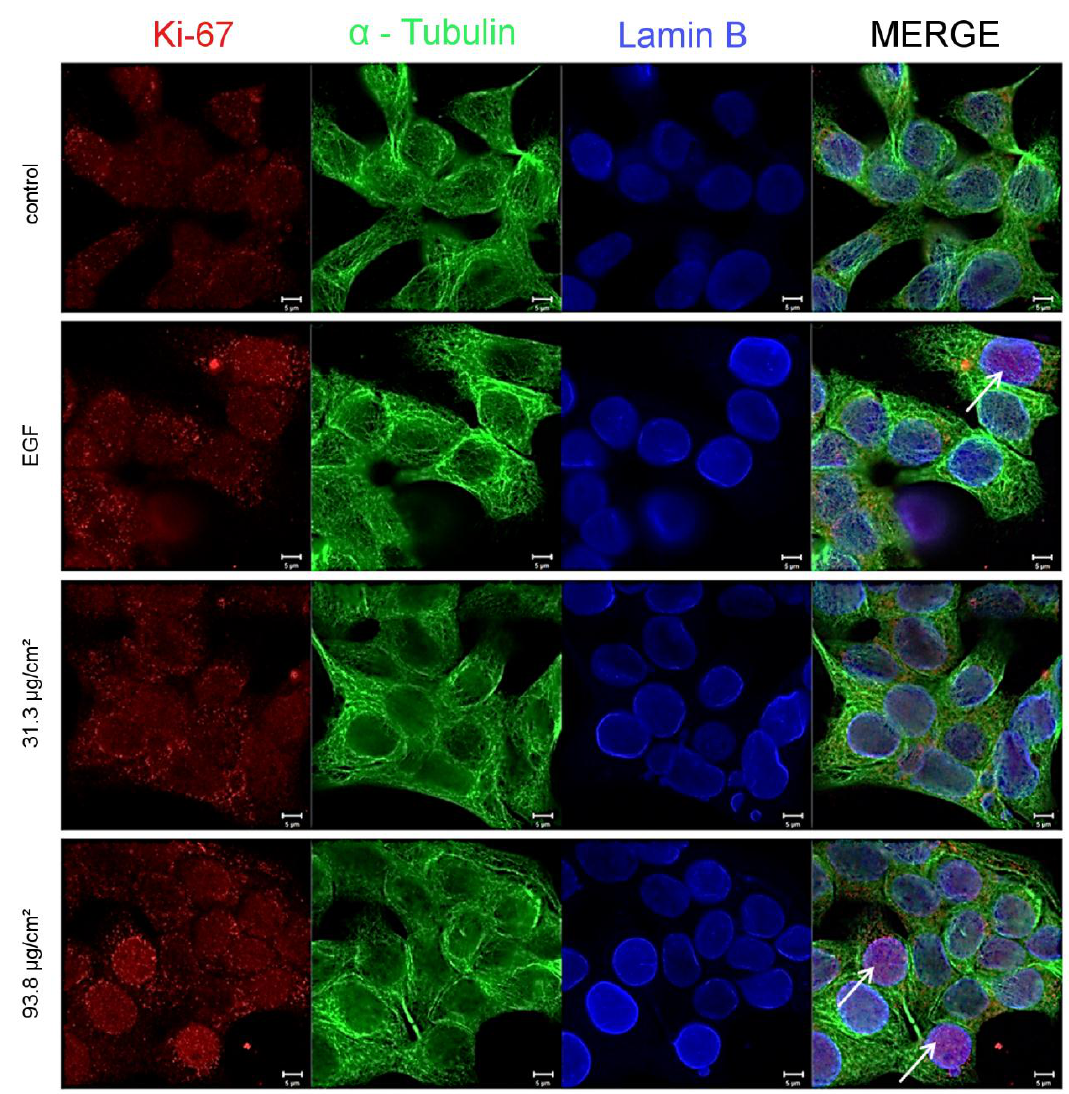
Figure 5. Intracellular levels and localization of Ki-67. Representative images of GXF251L cells treated with 12 nm SiO 2 NPs for 24 h after immunofluorescence staining of Ki-67 ( red ), α -Tubulin ( green ) and Lamin B ( blue ). White arrows indicate enhanced presence of Ki-67 in the nucleus. Scale bars are equivalent to 5 µm.